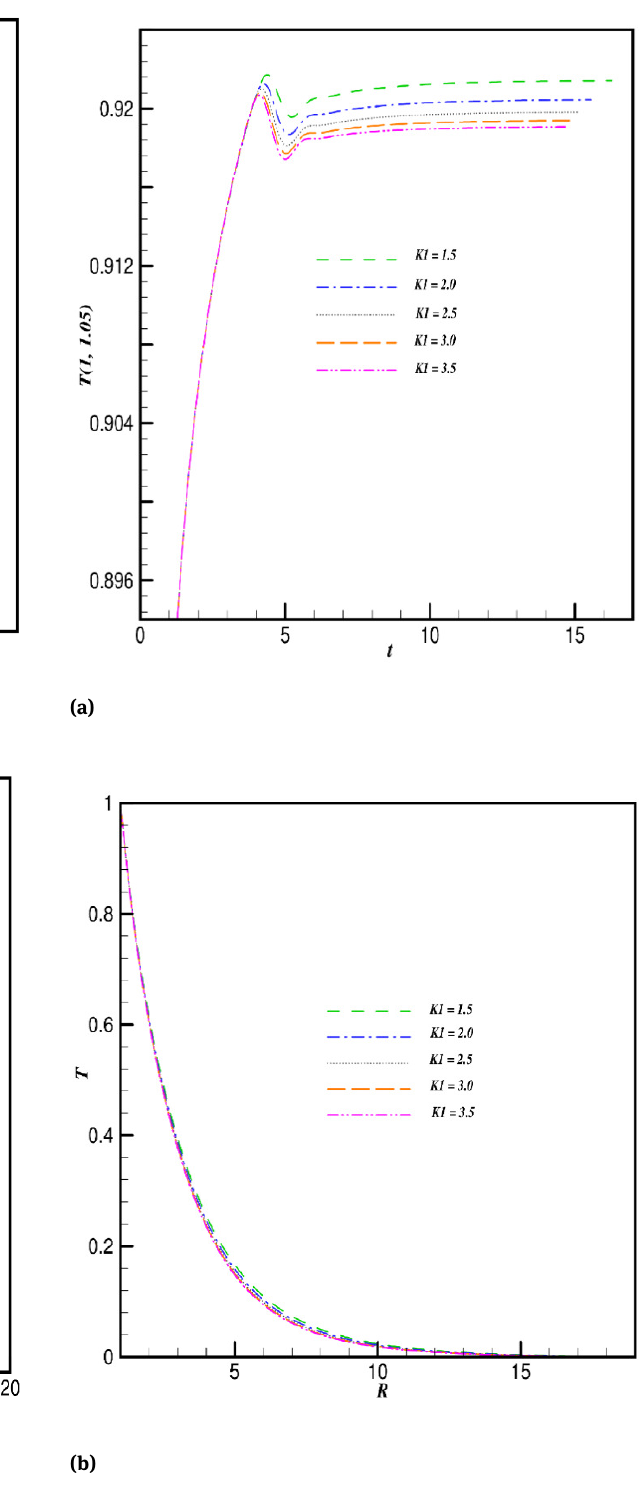
Figure 6: ( a ) Transient and ( b ) Steady state velocity profiles with fixed Sc = 0.6 , Pr = 0.7 , Bu = 1.0 , Kr = −0.2 , Nr = 1.0 , M = 0.2 , Ec = 0.1 .